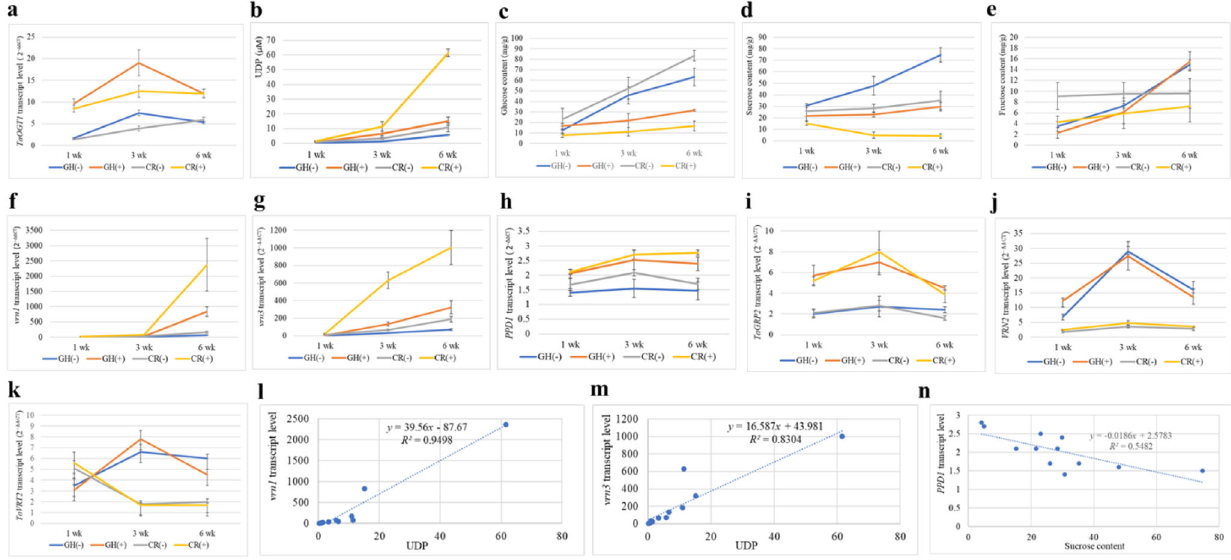
Fig. 6 Effects of TaOGT1b overexpression on sugar content and fl owering-time gene expression. a – k Comparison of gene expression and sugar content in TaOGT1b overexpressed transgenic plants ( + ) and non-transgenic plants ( − ). The plants were grown in the greenhouse (GH) without vernalization or were treated in a cold room (CR) with vernalization for 1 week (1 wk), 3 weeks (3 wk), or 6 weeks (6 wk). The same samples of fully developed leaves from three different plants with two technical replicates ( n = 6) were used to determine TaOGT1 transcript levels ( a ); O -GlcNAc transferase activity ( b ); the contents (mg g − 1 ) of glucose ( c ), sucrose ( d ), and fructose ( e ); and transcript levels of vrn1 ( f ), vrn3 ( g ), PPD1 ( h ), TaGRP2 ( i ), VRN2 ( j ), and TaVRT2 ( k ). Transcript levels were calculated using the 2 – ΔΔ CT method, where CT is the threshold cycle. The signi fi cant differences in mean expression for each gene were compared between the two alleles using a two-tailed unpaired Student ’ s t test (Supplementary Table 1); the bars indicate the standard error. l – n Correlation analyses of data for all transgenic and non-transgenic plants with and without vernalization ( n = 12): l. UDP vs. vrn1 ; m. UDP vs. vrn3 ; n sucrose vs. PPD1 . The signi fi cant correlations between two variables were shown in Supplementary Tables 2, 3. Source data underlying ( a – k ) are provided as a Source Data fi